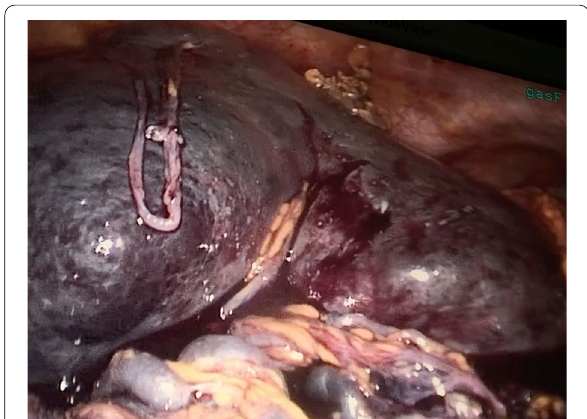
Fig. 2 Splenic infarction with hypertrophic hilar vessels